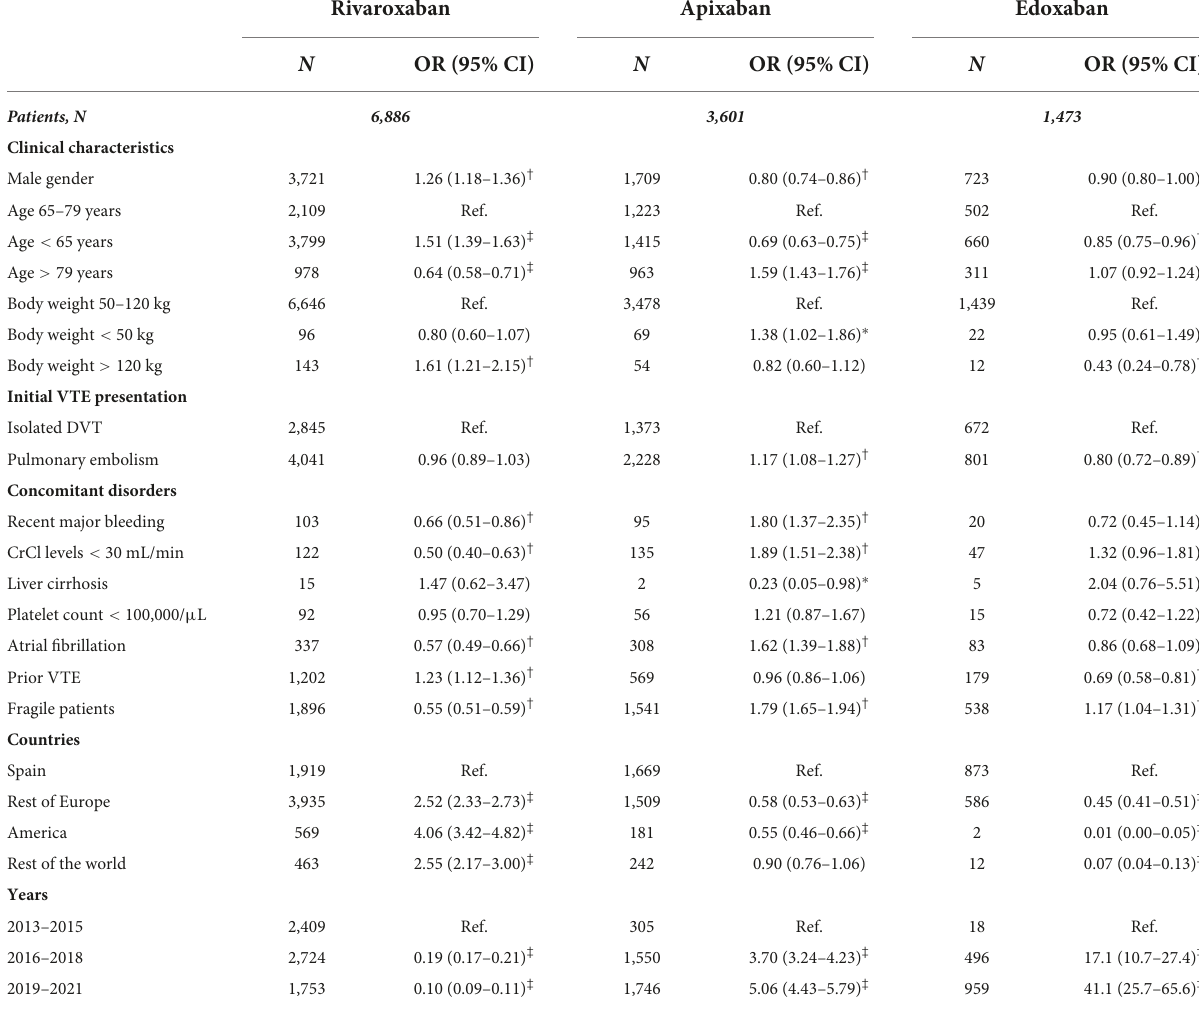
TABLE 4 Univariable analyses for predictors of use of each DOAC vs. the rest of DOACs.